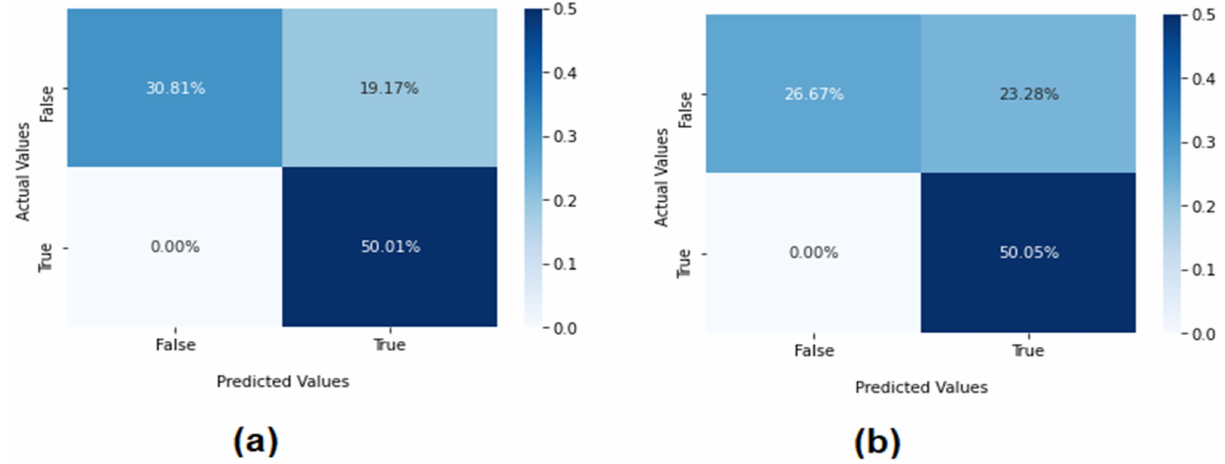
Figure 9. The confusion metrics for ( a ) the KNN method and ( b ) the LDA method.